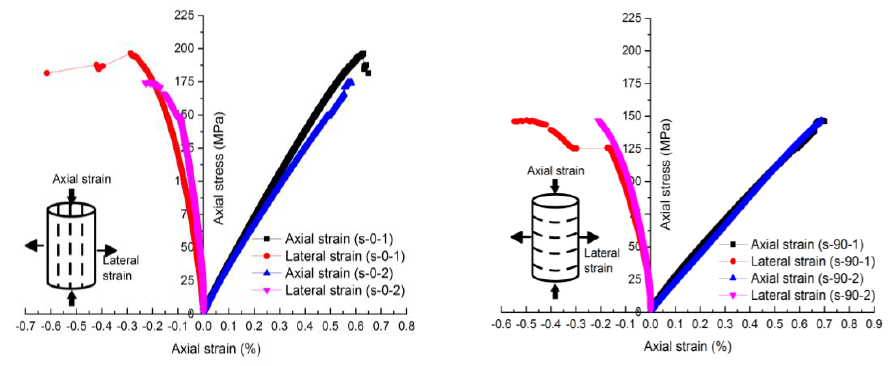
Figure 2. Typical stress strain curves for shale samples (50 mm × 100 mm) with orientation of 0° and 90°, respectively. Table 1. The five elastic parameters for the black Longmaxi shale. Group No.